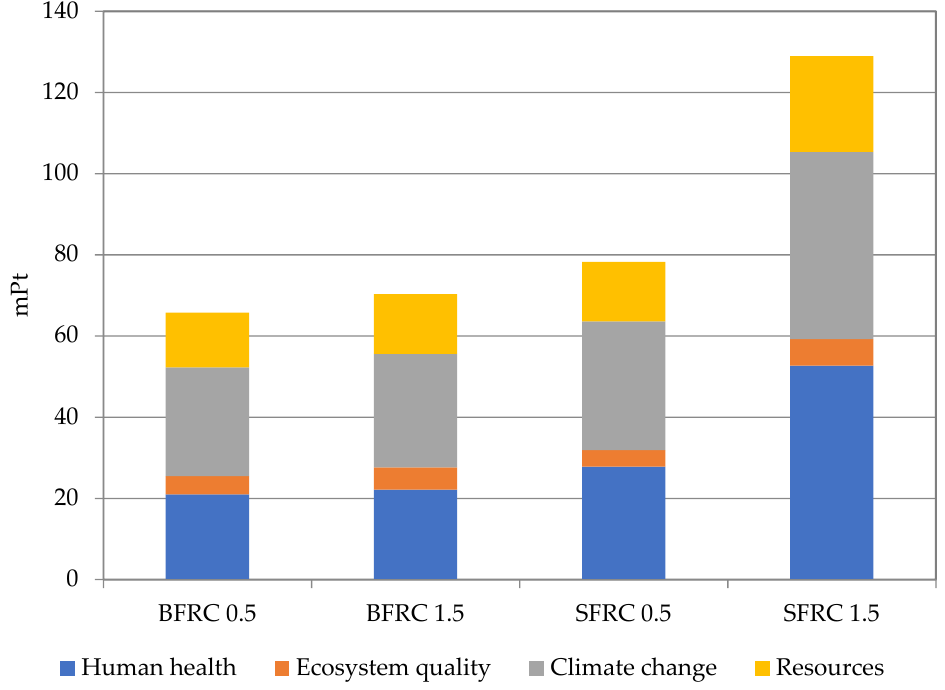
Figure 5. Endpoint comparison of concrete reinforced by basalt and steel fibers.